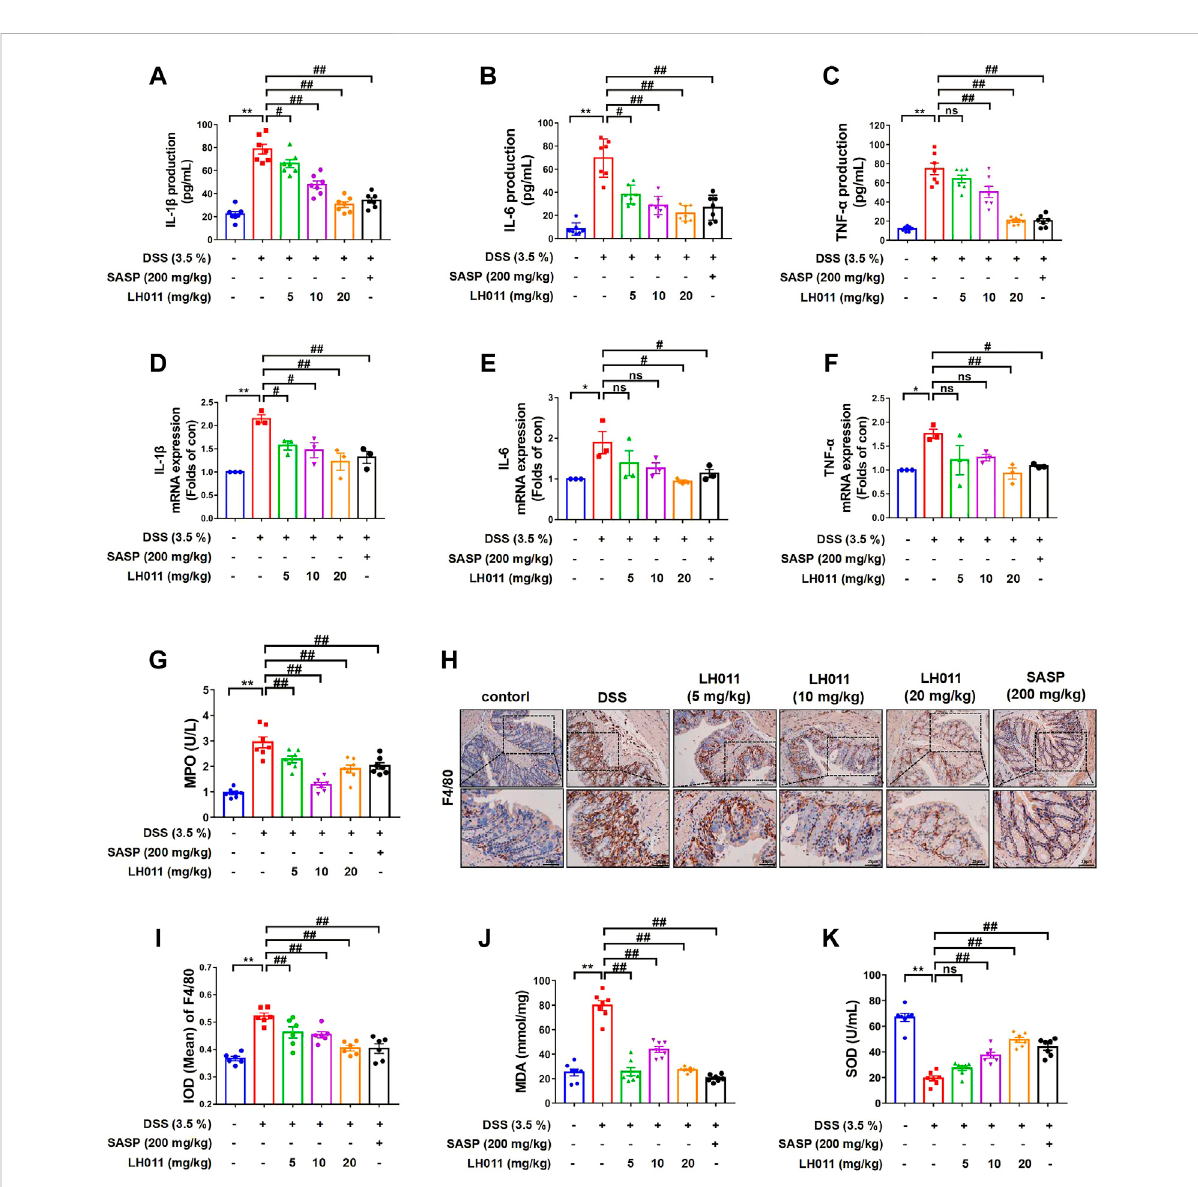
FIGURE 2 LH011 relieved in fl ammation and oxidative stressesin thecolonic tissue. (A – C) Serum levels of IL-1 β , IL-6, and TNF- α . n = 7. (D – F) mRNA levels ofIL-1 β ,IL-6,andTNF- α inthecolonictissue.n=3. (G) LevelsofMPOinthecolonictissue.n=7. (H,I) RepresentativeIHCresultsofF4/80toindicate the in fi ltration of macrophage, and the results were analyzed by Image Pro-Plus 6.0, scale bar: 100 μ m n = 6. (J,K) Levels of MDA and SOD in the colonic tissues. n = 7. All data are presented as the mean ± SEM. * p < 0.05, ** p < 0.01 vs. control group; # p < 0.05, ## p < 0.01 vs. DSS group; ns, no signi fi